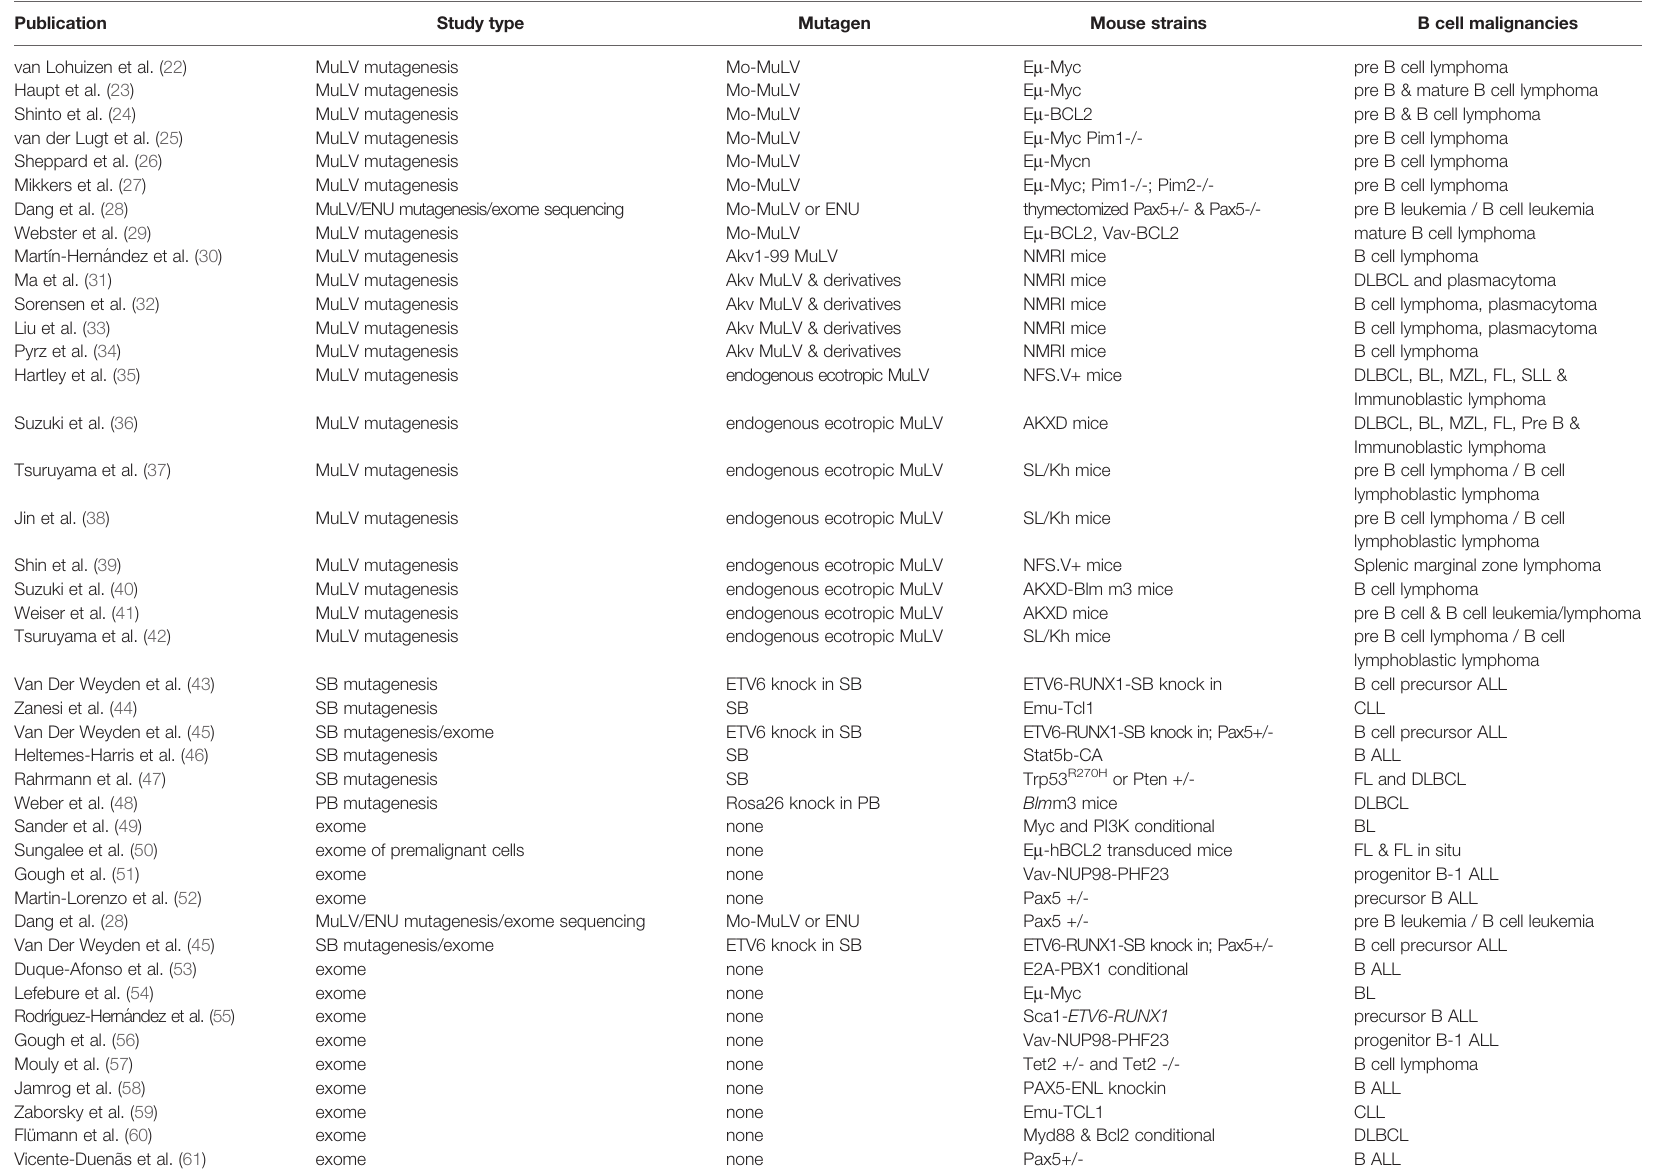
TABLE 2 | Forward genetic screens in mouse models of B cell